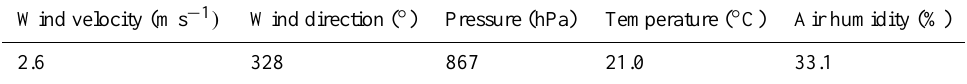
Table 2. Meteorological